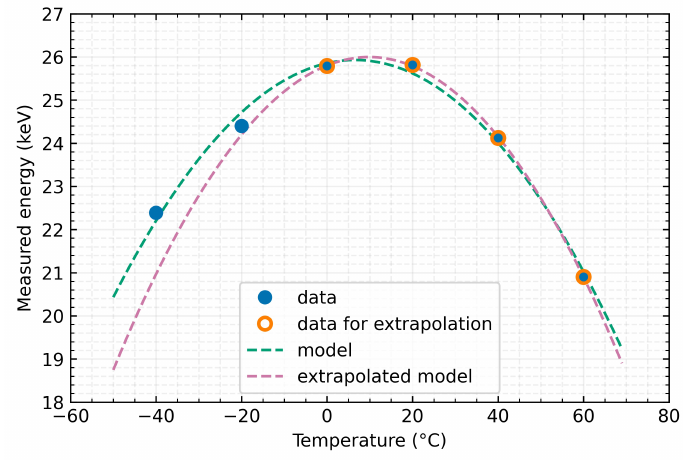
Figure 9. Model of temperature compensation of energy measurement (X-ray fluorescence with Tin target and detector in Time-over-Threshold mode of measurement and data-driven readout mode) distortion using Timepix3 detector with 1000µm Silicon sensor in the temperature range from to 60°C. Extrapolated model based on data measured in temperatures above 0°C is shown as well.